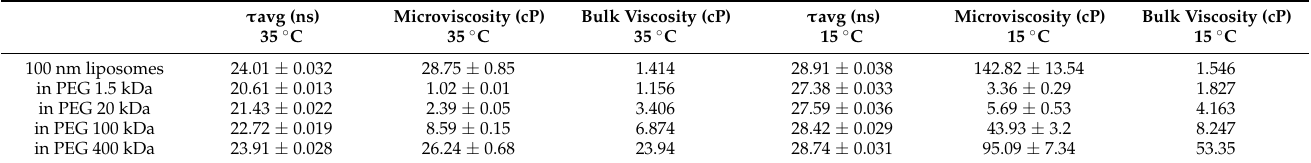
Figure 6. Average fluorescence lifetime of Oil Red O in methanol–glycerol mixtures of various compositions plotted against viscosity at ( A ) 15 ◦ C and ( B ) 35 ◦ C. Error bars represent standard deviation; measurements were repeated three times. Time-resolved fluorescence decays of Oil Red O inside lipid bilayer in the presence of different PEG M w values at ( C ) 15 ◦ C and ( D ) 35 ◦ C. Table 2. Lifetime of Oil Red O and microviscosity of lipid membranes in 100 nm liposome solutions in the absence and presence of PEG with various M w